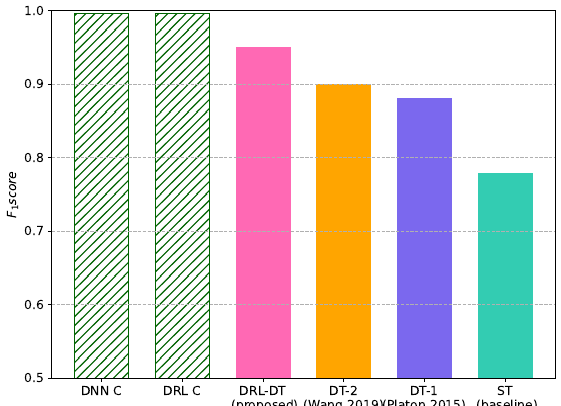
Figure 13. F 1 score comparison between model-based fault detection schemes [15,49].